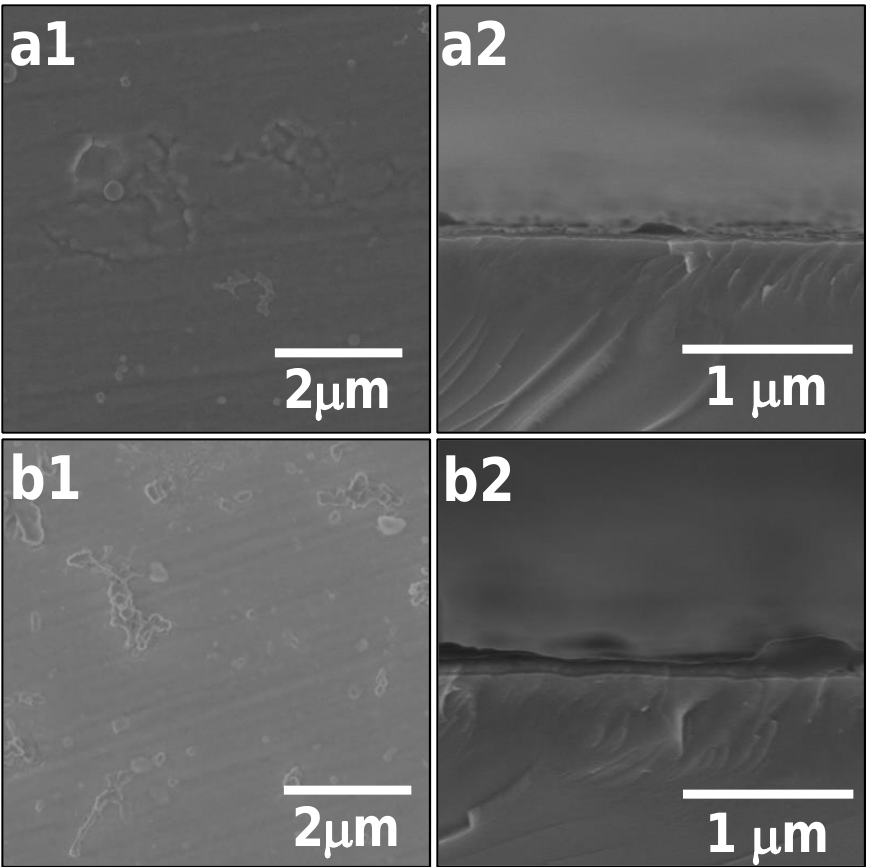
Figure 5. SEM images of SiO 2 /ZrO 2 -coated substrates. Images ( a1 ) and ( a2 ) show SEM images of the surface and cross-section of SiO 2 /ZrO 2 -coated substrate after one round of ZrO 2 -coating, respectively. Images ( b1 ) and ( b2 ) show SEM images of the surface and cross-section of SiO 2 /ZrO 2 -coated substrate after three rounds of ZrO 2 -coating, respectively. The pre-SiO 2 -coating for the raw substrate was performed three times prior to ZrO 2 -coating.